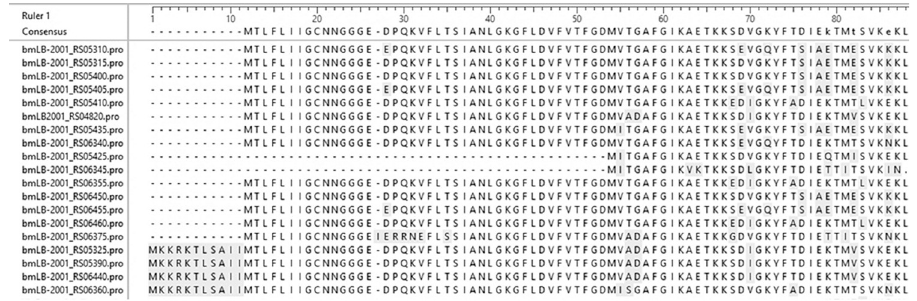
Fig 5. Amino acid alignment of the N-terminal coding sequence for the LB-2001 delta family Vlps as encoded by the archived genes. The proteins are annotated according to GenBank accession GCF_017748095.1. Shaded areas represent amino acid differences from consensus and illustrate the 4 genes that begin with MKKRKTLSAII and the beginning of divergence for individual pseudogenes translations following N-terminal conservation.